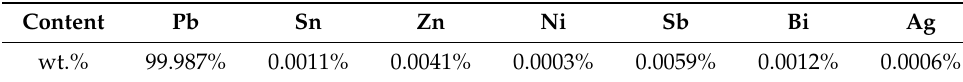
Table 1. Chemical composition of the Pb